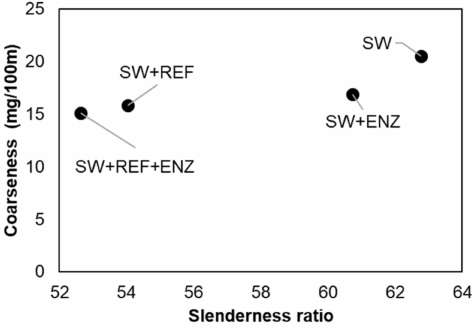
Figure 2. Coarseness as a function of the slenderness ratio of softwood fiber pulp (SW) with enzymatic treatment (SW + ENZ), with refining (SW + REF) and with the combination of both fiber modification treatments (SW + REF + ENZ).